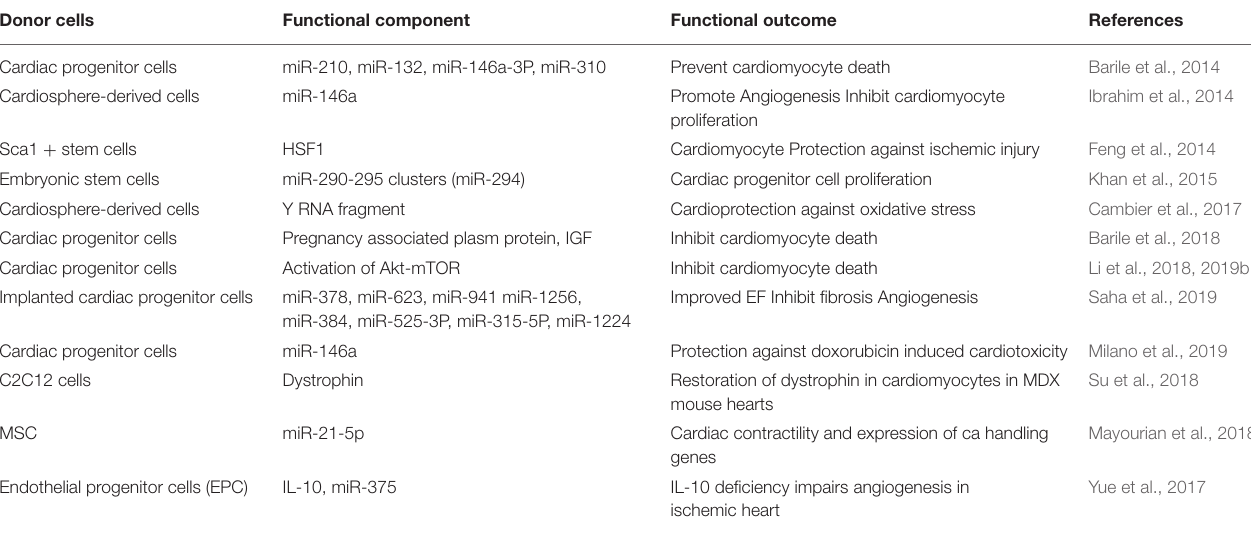
TABLE 5 | Stem cell/cardiac progenitor cell-derived exosomes for cardiac